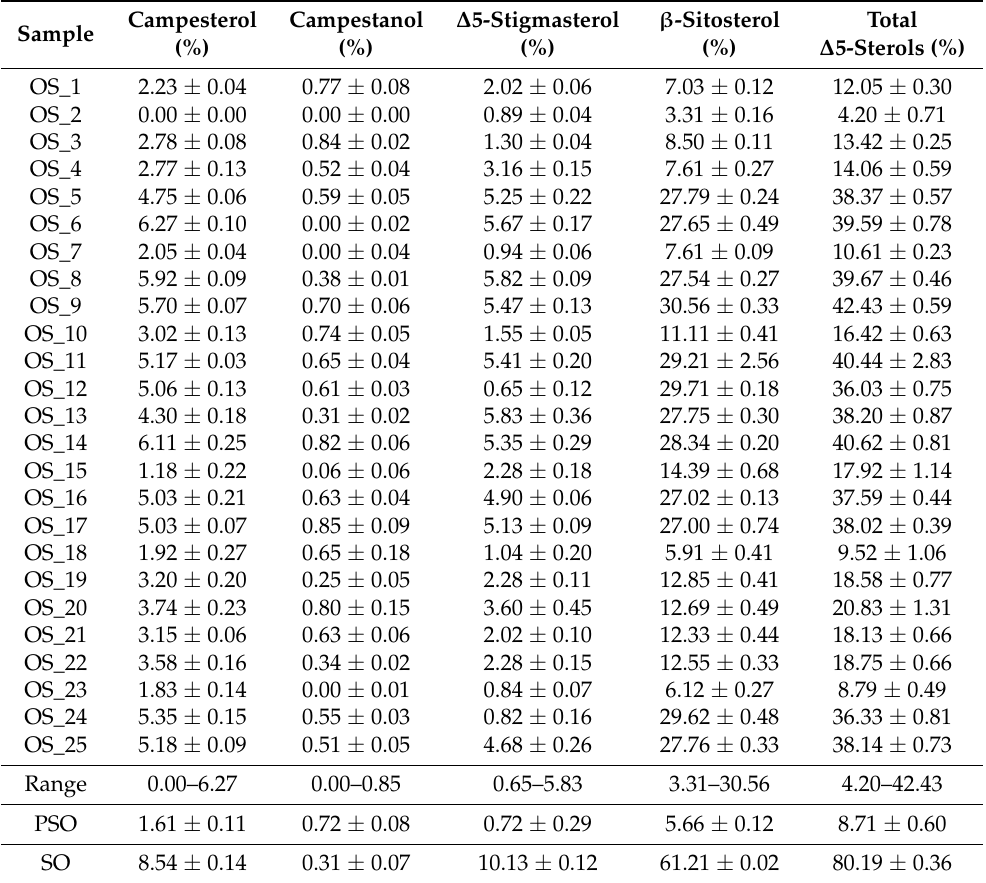
Table 1. ∆ 5-sterols (mean ± standard deviation, n = 3) in analysed oil samples (OS_1–25—samples labelled as pumpkin seed oils obtained from market, PSO—pumpkin seed oil produced in a laboratory, SO—refined sunflower